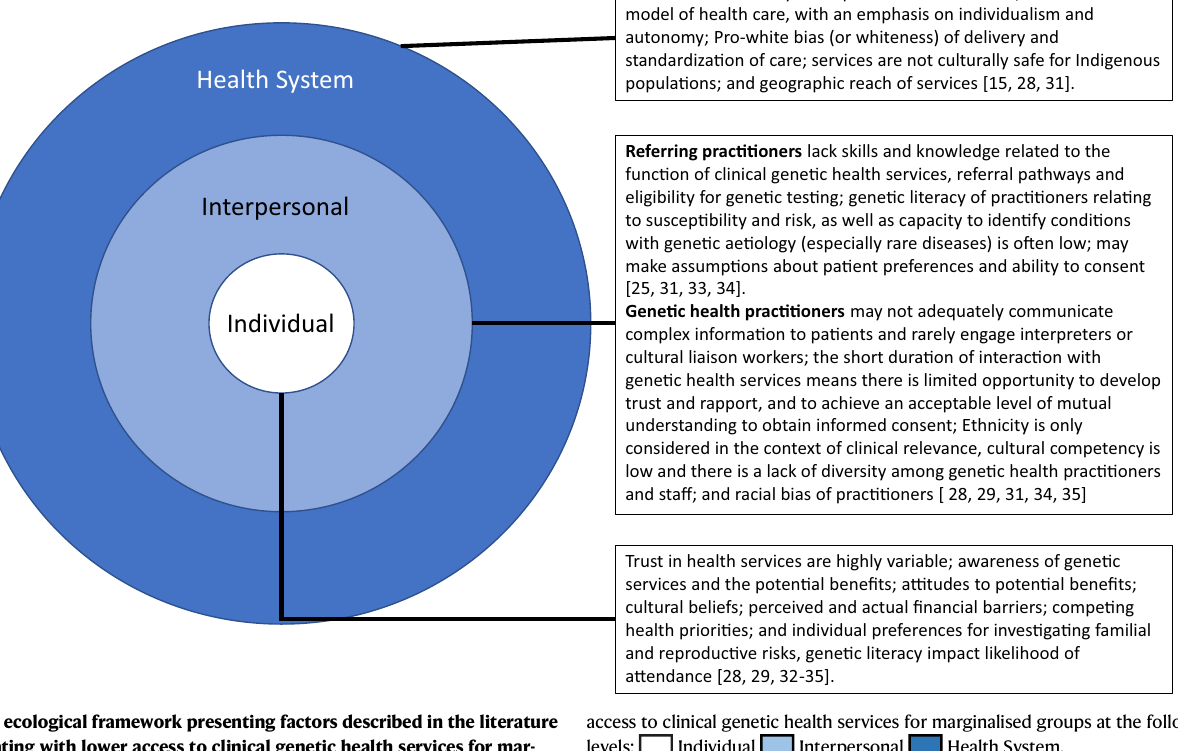
Fig. 1 | An ecological framework presenting factors described in the literature as associating with lower access to clinical genetic health services for mar- ginalised groups. Factors identi fi ed in the literature as associating with lower